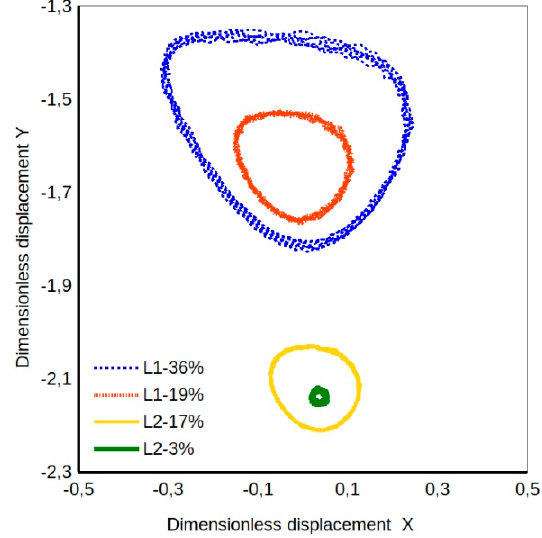
Figure 5. Orbits generated by the rotating force for the four-pad TPJB. Red and blue lines for the lower static load L1 and increasing dynamic / static load ratio, and green and yellow for the higher static load L2 and increasing dynamic / static load ratio.